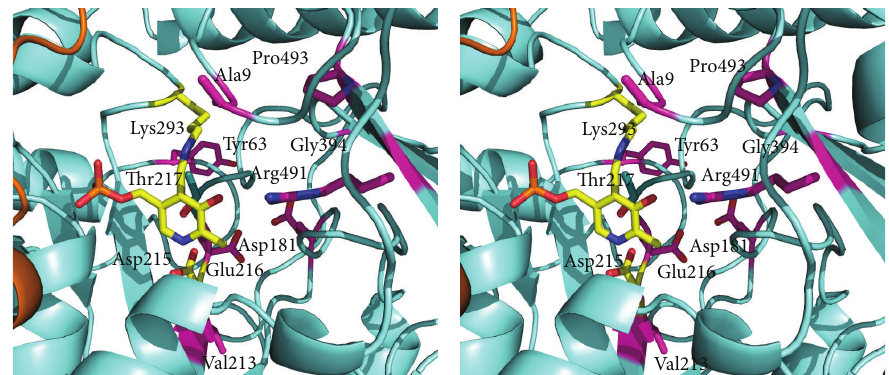
Figure 7: Stereo picture of the active site of the model of the AAT domain. Stereo picture of the active site of the model of the AAT domain of the MocR from Saccharopolyspora erythraea (RefSeq code WP 009946170). Pyridoxal phosphate, Lys forming the internal aldimine, and the Asp interacting with the pyridine nitrogen atom are represented as yellow stick models. Residues indicated as SDPs are colored in magenta. Numbering system refers to Figure 5.